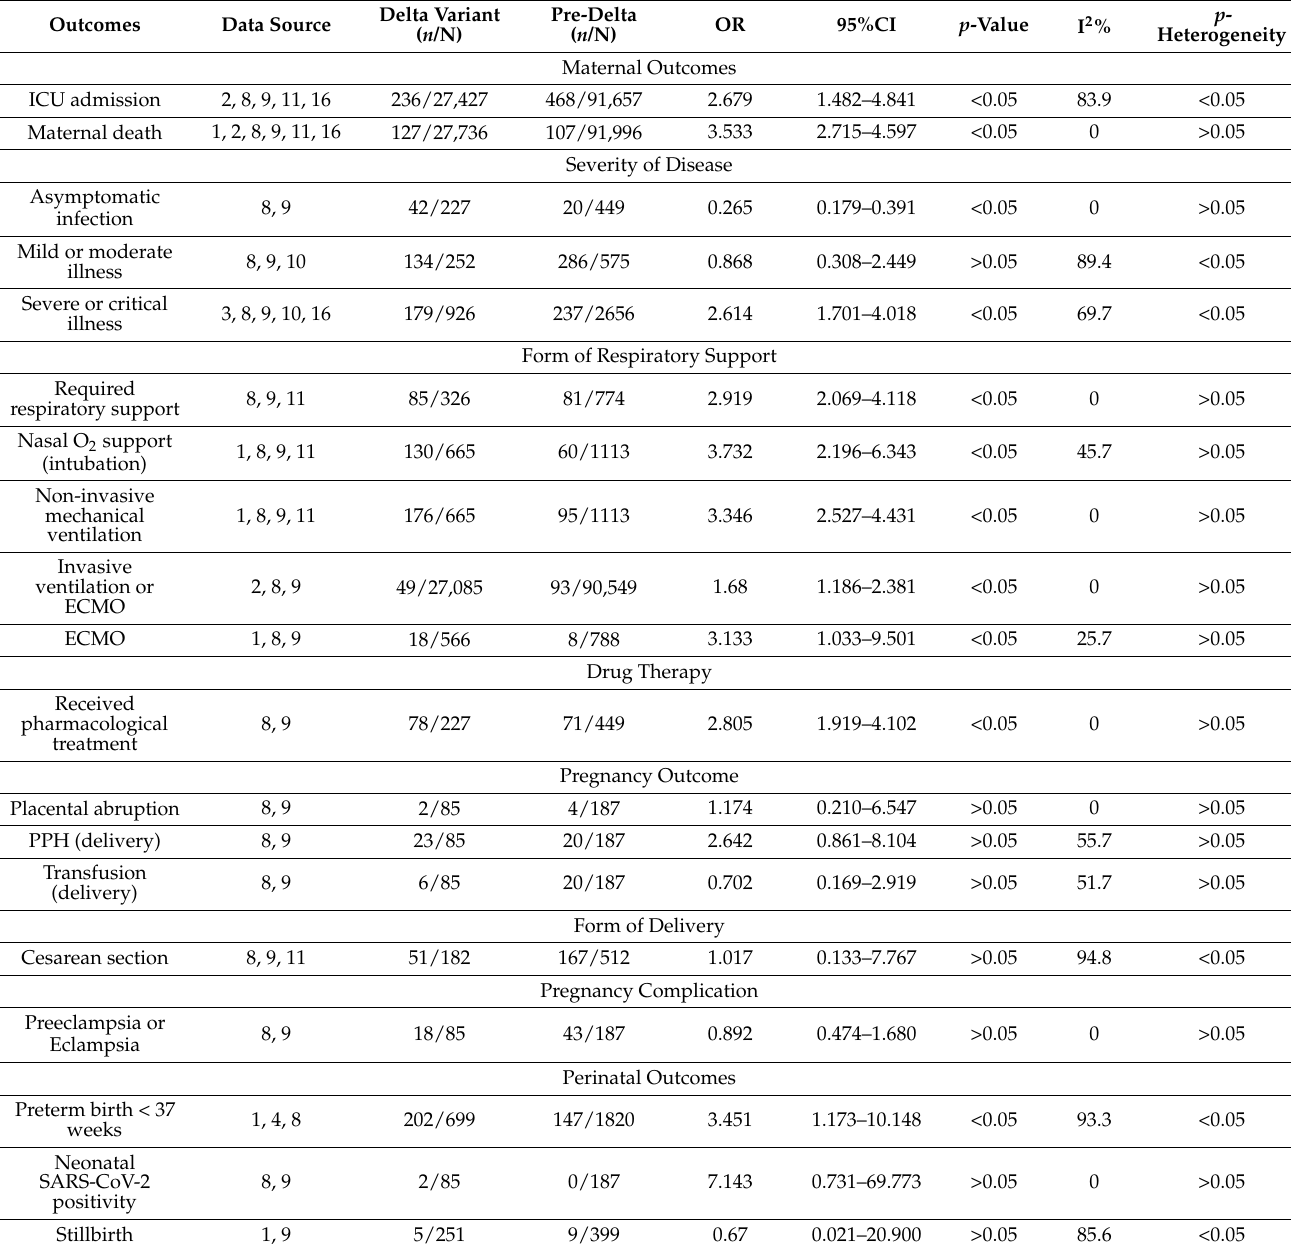
Table 2. Maternal and perinatal outcomes of Delta or pre-Delta SARS-CoV-2 variant infections during